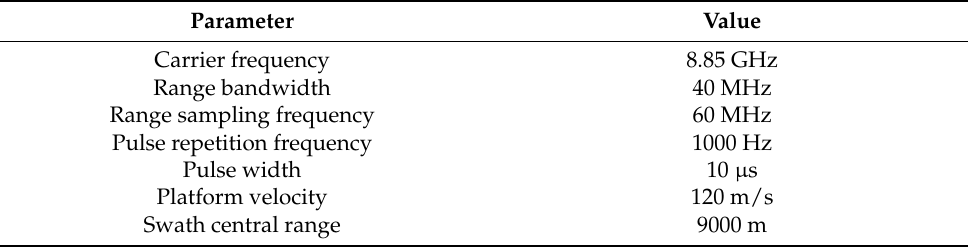
Table 4. X-band SAR system